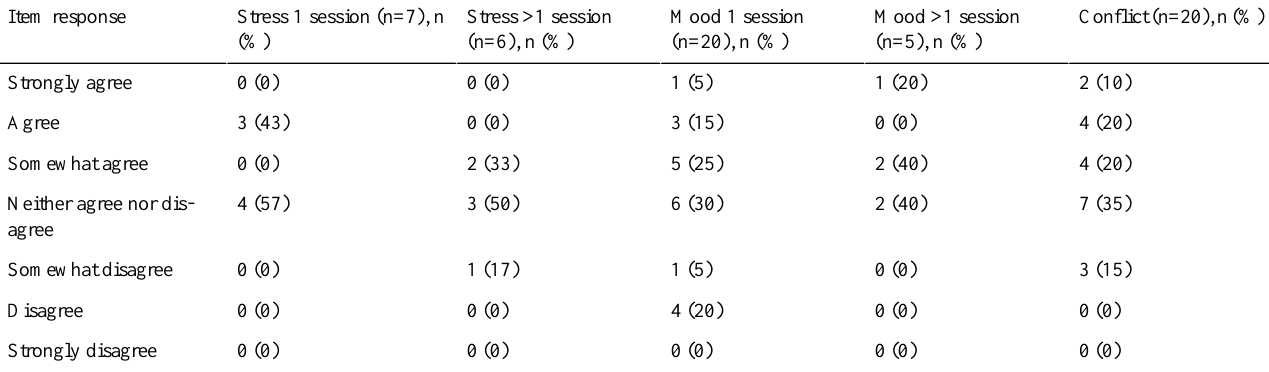
Table 5. Analysis of responses to the Acceptability of Self-Guided Treatment item “I would rather use a computer to help myself privately than go to a